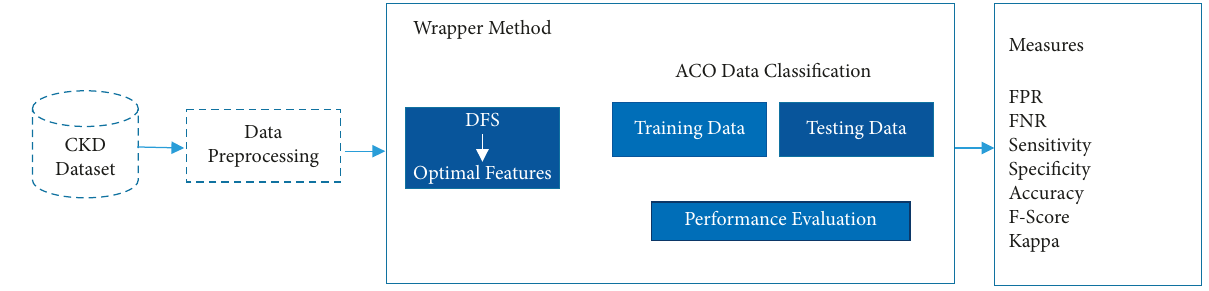
Figure 1: Use of ML classifiers on CKD data set